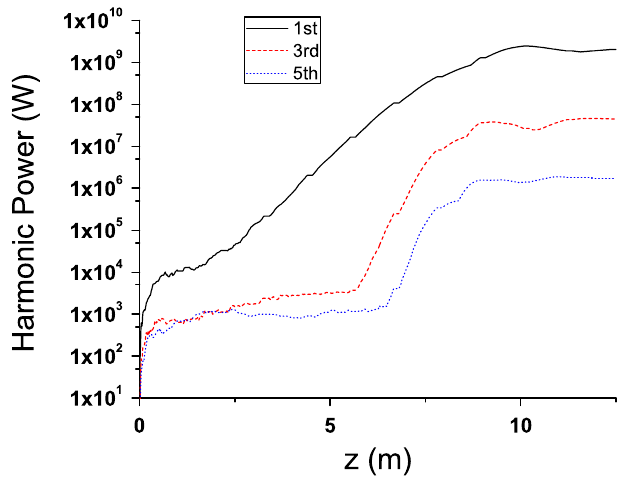
FIG. 6. (Color) Harmonic gain of the SPARX ultrashort low- charge beam lasing in the cryogenic hybrid praseodymium